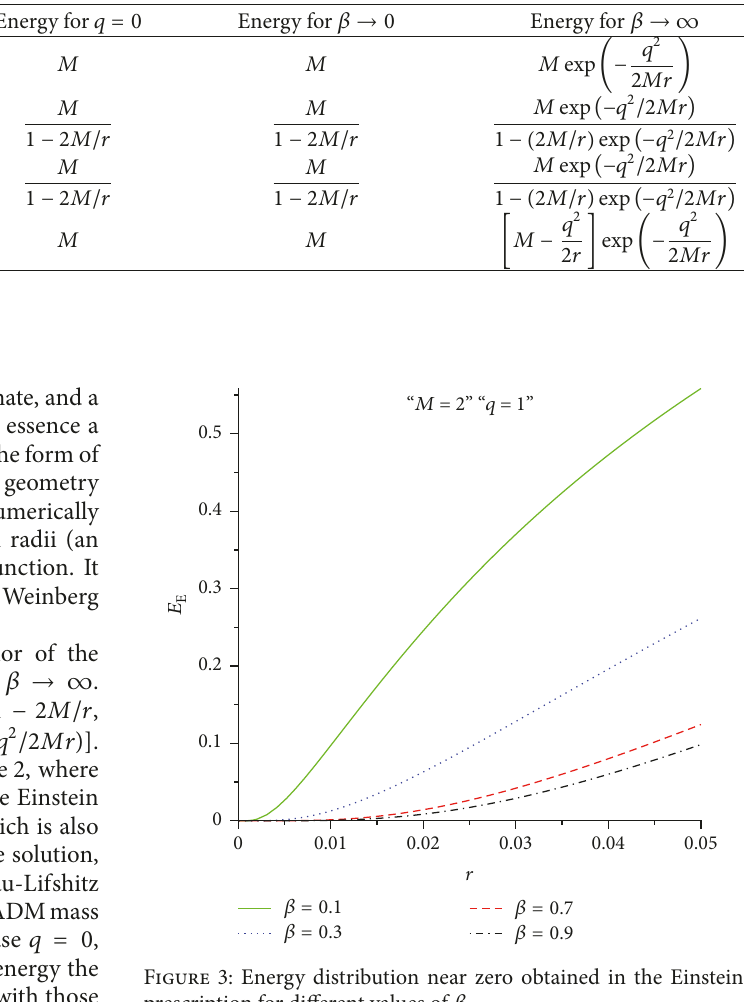
Table 2: Limiting cases for the energy.